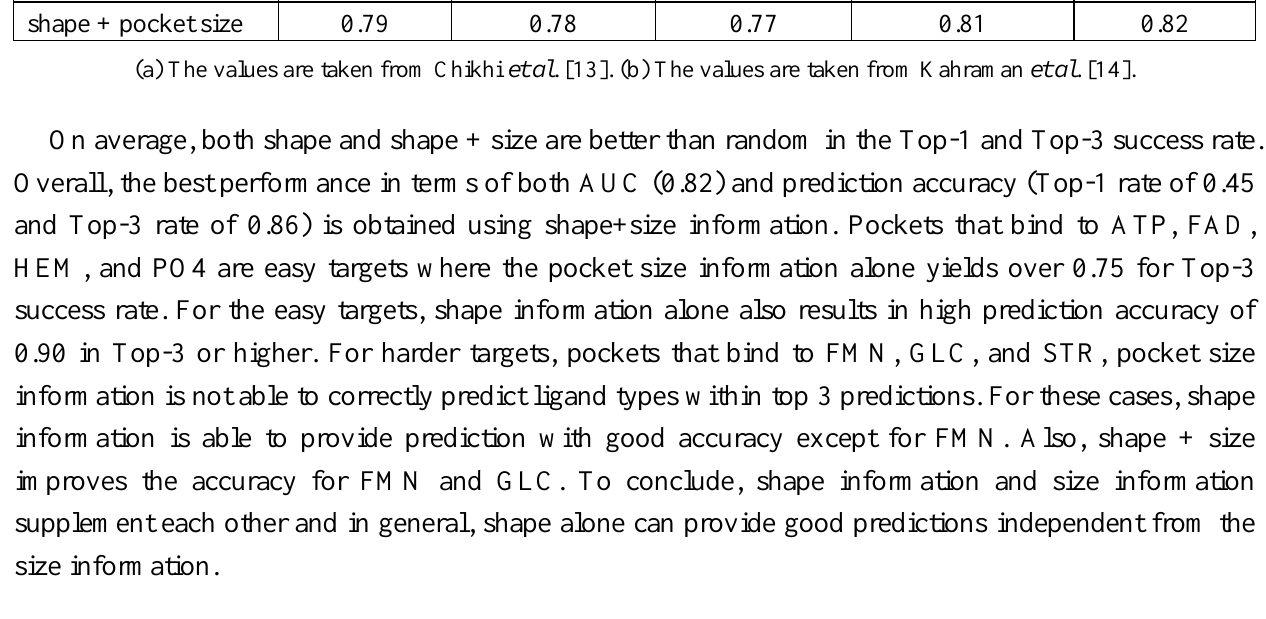
Table 3. Performance of the local patch method for individual ligand